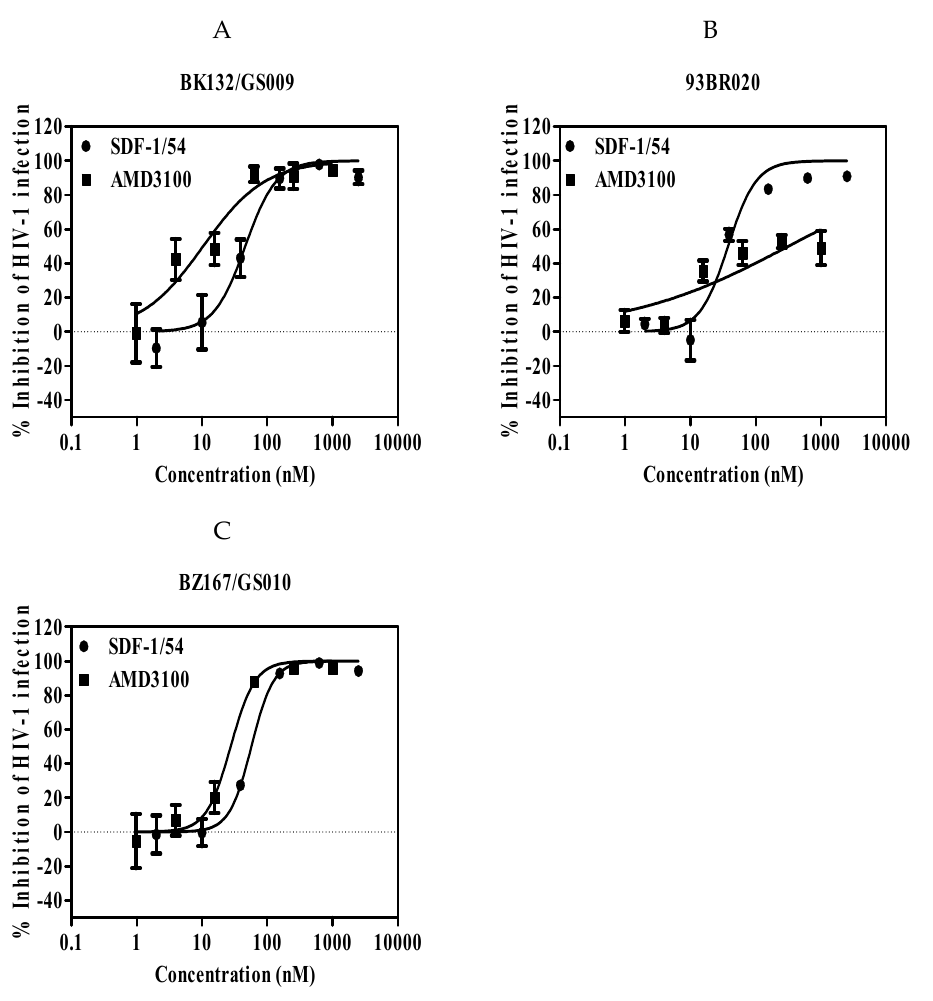
Figure 3. SDF-1 / 54-mediated inhibition of infection by primary HIV-1 isolates of TZM-bl cells. Inhibition of the primary X4-tropic HIV-1 isolates included BK132 / GS009 ( A ), 93BR020 ( B ) and BZ167 / GS010 ( C ). TZM-bl cells were pre-incubated with graded concentrations of SDF-1 / 54 for 15 min at 37 ◦ C. Next, primary HIV-1 isolates were added to the mixture. At 48 h post-infection, luciferase activity was detected. Average values ( ± SD) from three independent experiments are shown. Table 3. The inhibitory activities of SDF-1 / 54 on infection by primary HIV-1 strains in TZM-bl